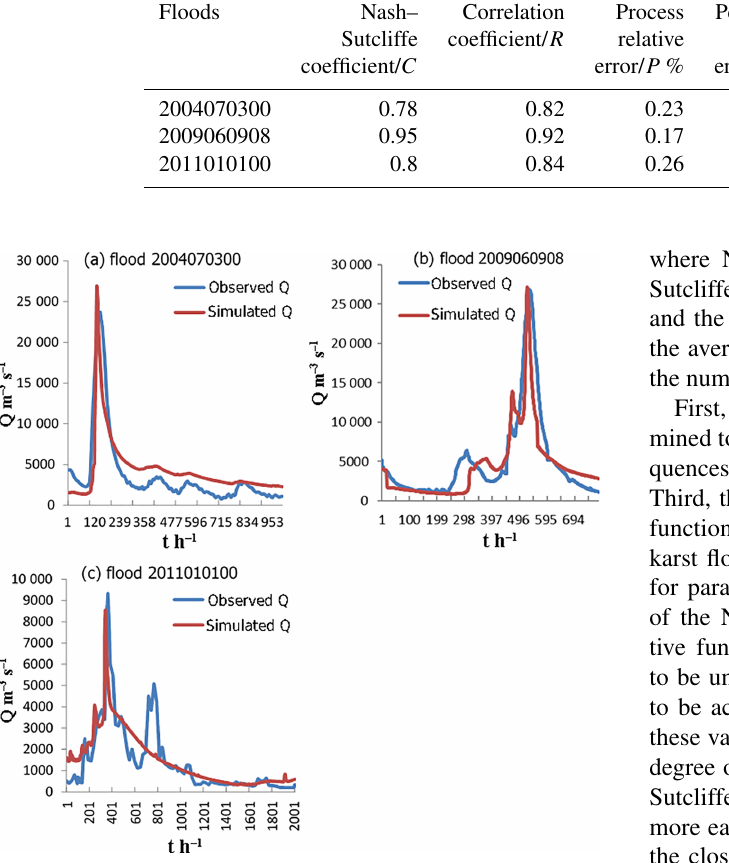
Figure 11. The flood simulation results obtained through parameter optimization by the improved PSO